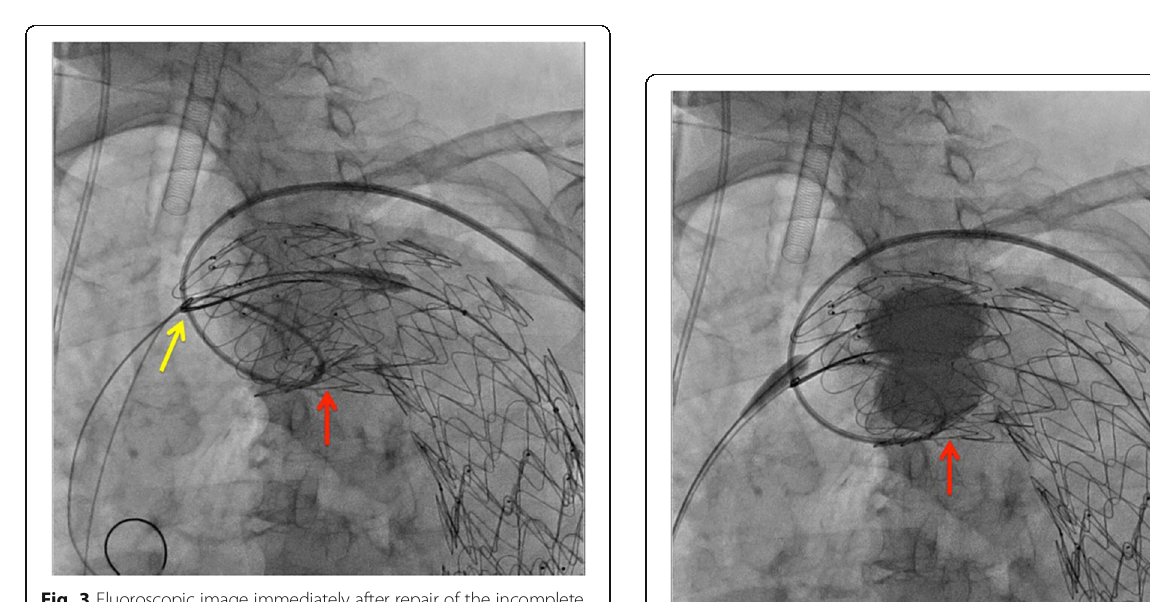
Fig. 2 Schema of the double-snare technique. a Snare grasping of the distal side of the guiding sheath via left brachial artery. b Pulling the snare wire and advancing the guiding sheath toward the inner curved side of the proximal portion of the SG. c Passing the Radifocus GW through the temporarily opened snare loop. d The hard loop structure (guiding sheath end/IMA catheter/GW) under the inner curved side of the proximal portion of the SG. e , f Pulling the guiding sheath toward the left subclavian artery and repositioning (yellow arrow) the inner curved side of the proximal portion of the SG